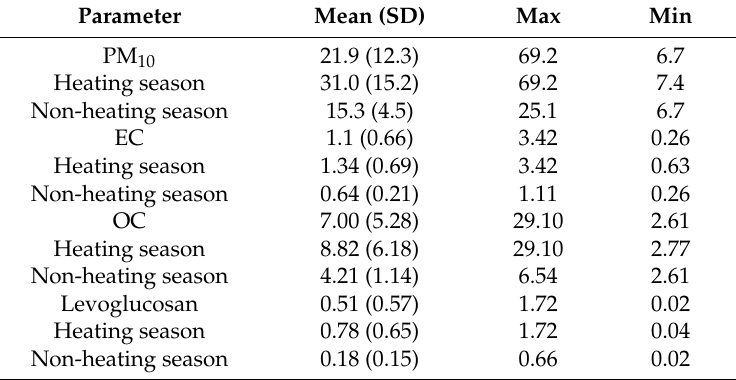
Table 2. The average concentration of PM 10 ( µ g · m − 3 ), EC ( µ g · m − 3 ), OC ( µ g · m − 3 ), and levoglucosane ( µ g · m − 3 ) during the heating and non-heating periods at the site of Krynica